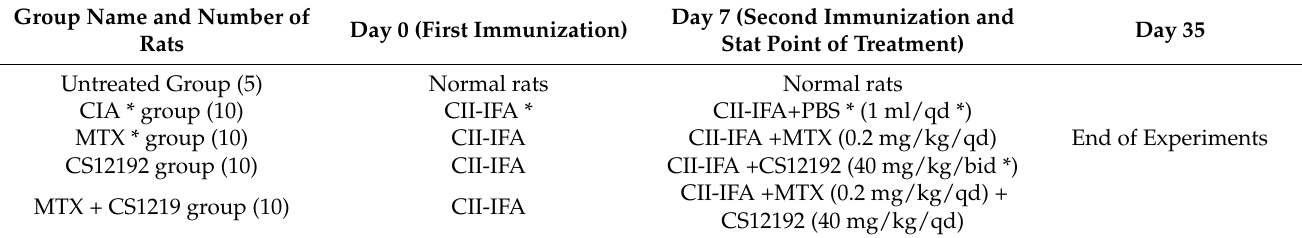
Table 1. Experimental Design of the current